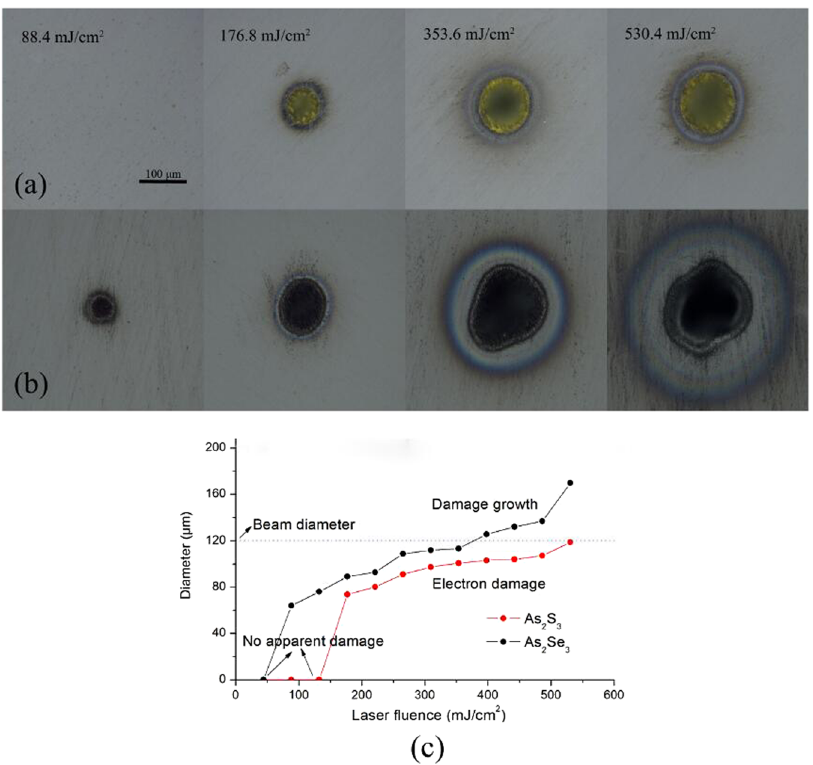
Figure 3. Optical micrographs of multi pulses damaged As 2 S 3 ( a ) and As 2 Se 3 ( b ) at a range of laser fluences. ( c ) The diameter of damage crater observed by optical microscope as a function of laser